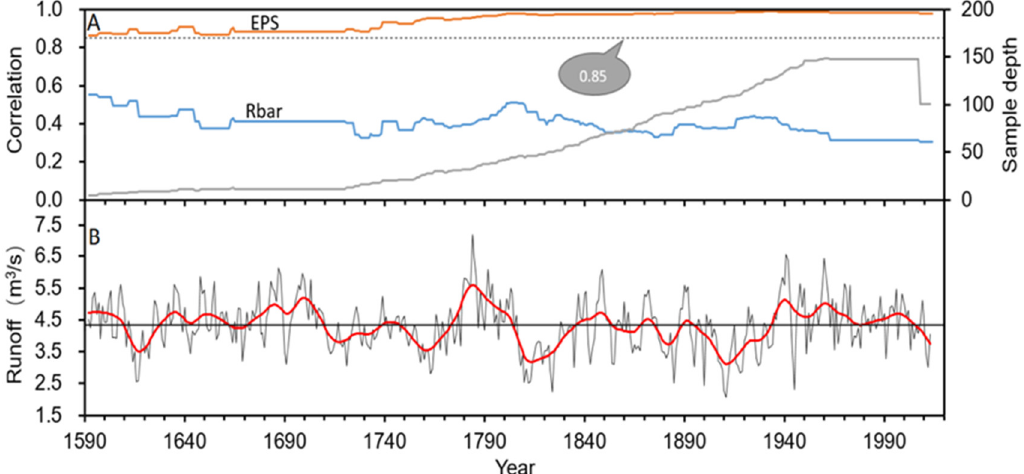
Figure 5. ( A ) The sample depth, running series of mean correlation (Rbar) and expressed population signal (EPS) of the regional tree-ring chronology. ( B ) Reconstructed (black line) and 21-year low-pass filtered (red line) runoff of the Kaiken River from 1592 to 2013. Central horizontal line (dotted line) shows average value of reconstructed runoff series.